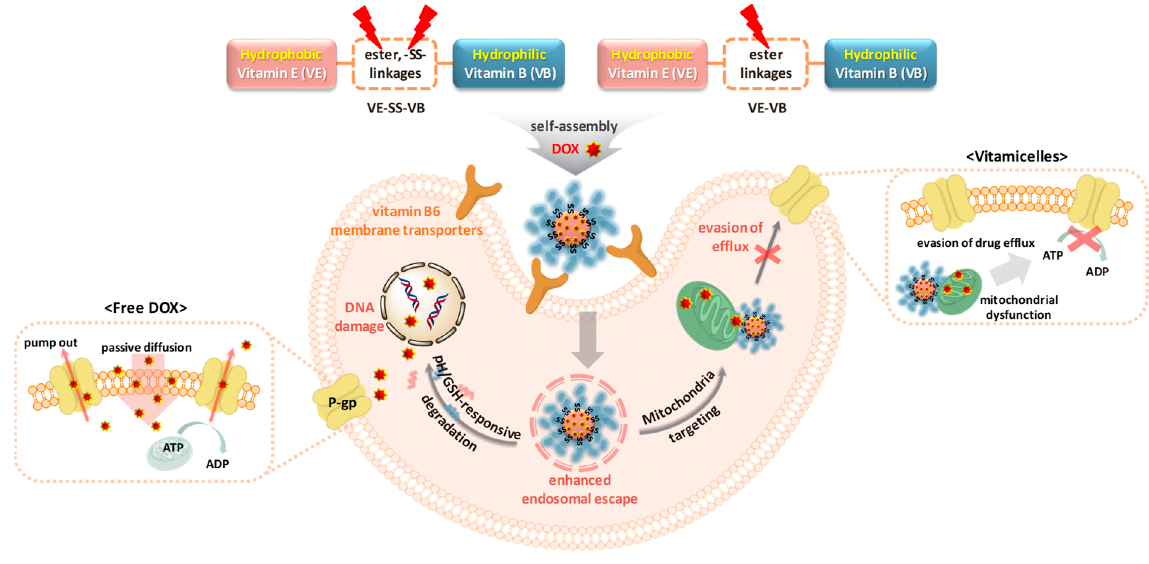
Figure 1. Schematic illustration of the mechanism underlying cancer cell apoptosis induced by dual stimuli-responsive degradable vitamicelles.